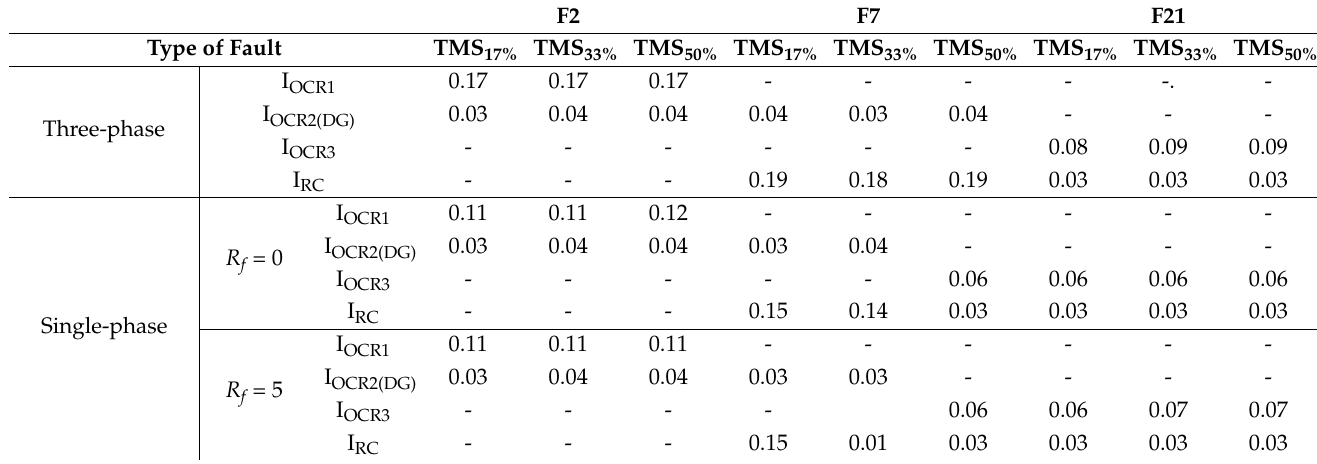
Table A2. Relay TMS values for the different scenarios